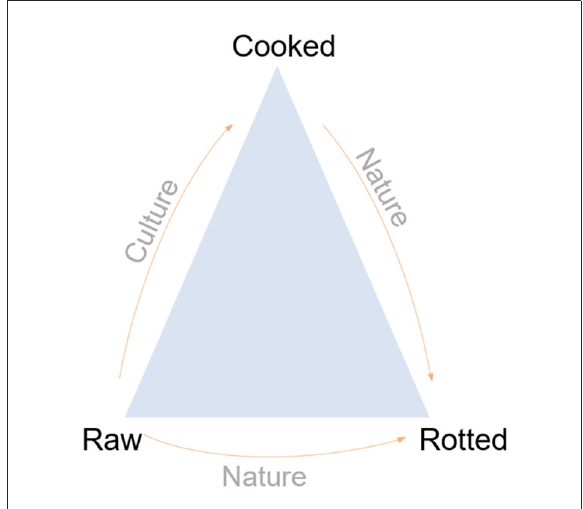
FIGURE1 The culinary triangle. Lévi-Strauss (5, 25) with